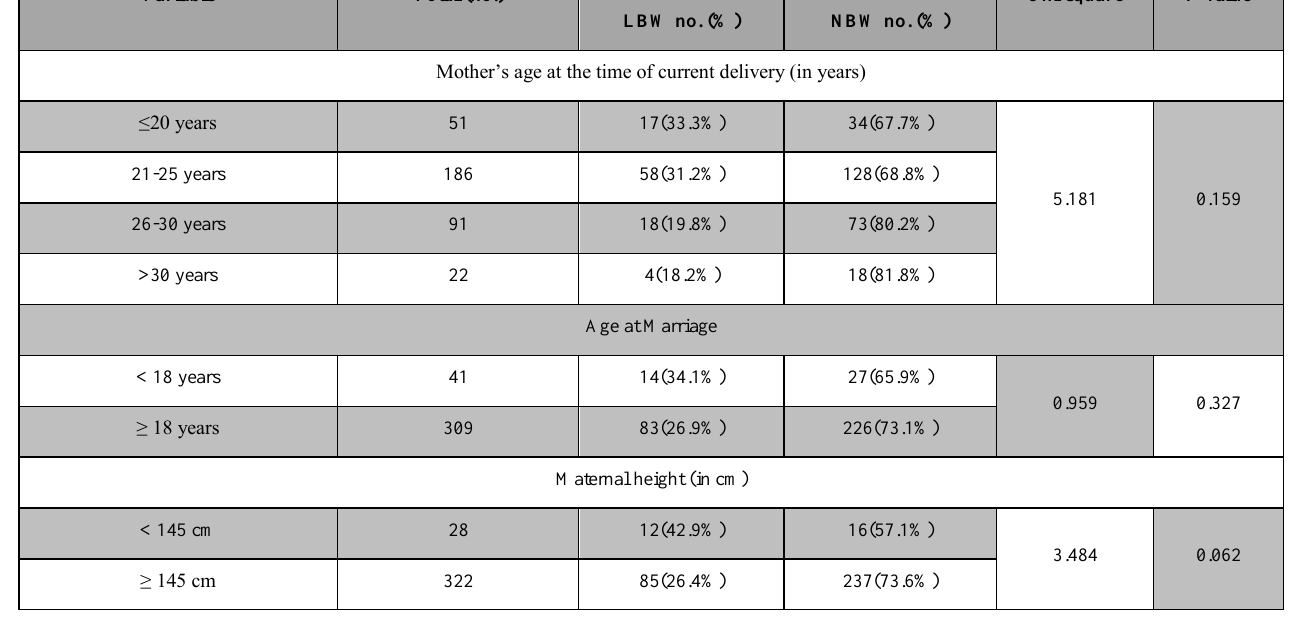
Table 2. Association of low birth weight with maternal age, age at marriage, and maternal height (n= 350). Variable